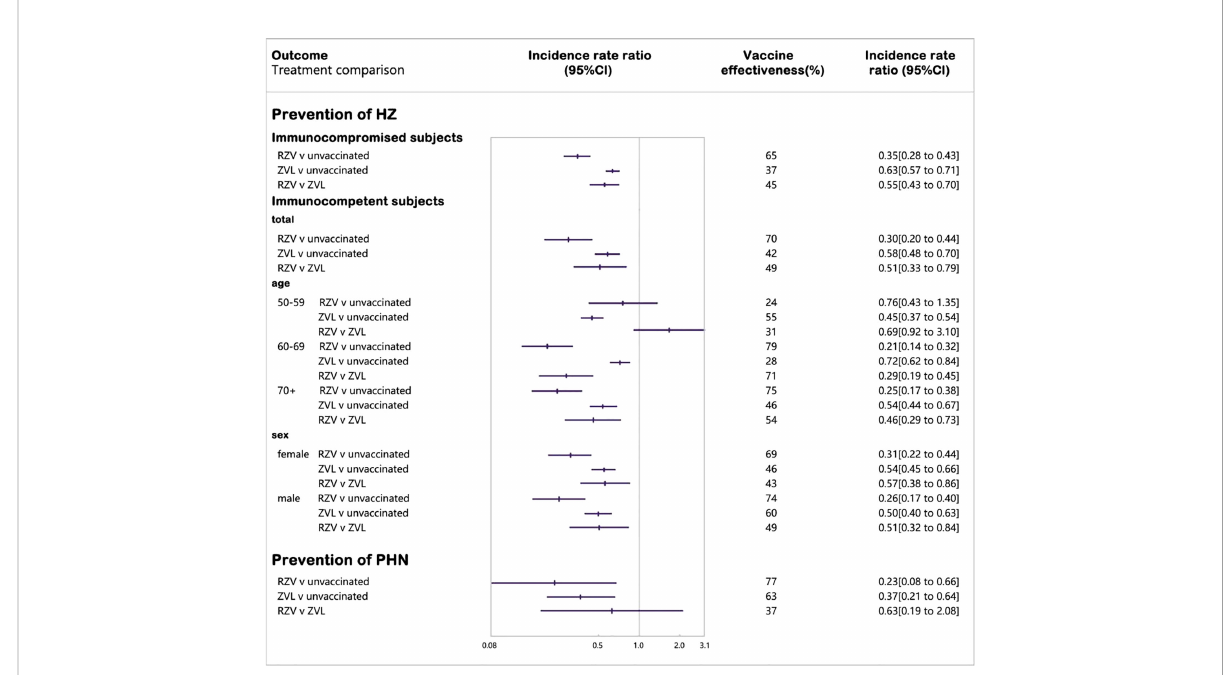
FIGURE 3 Forest plot of vaccine effectiveness in reducing cases of herpes